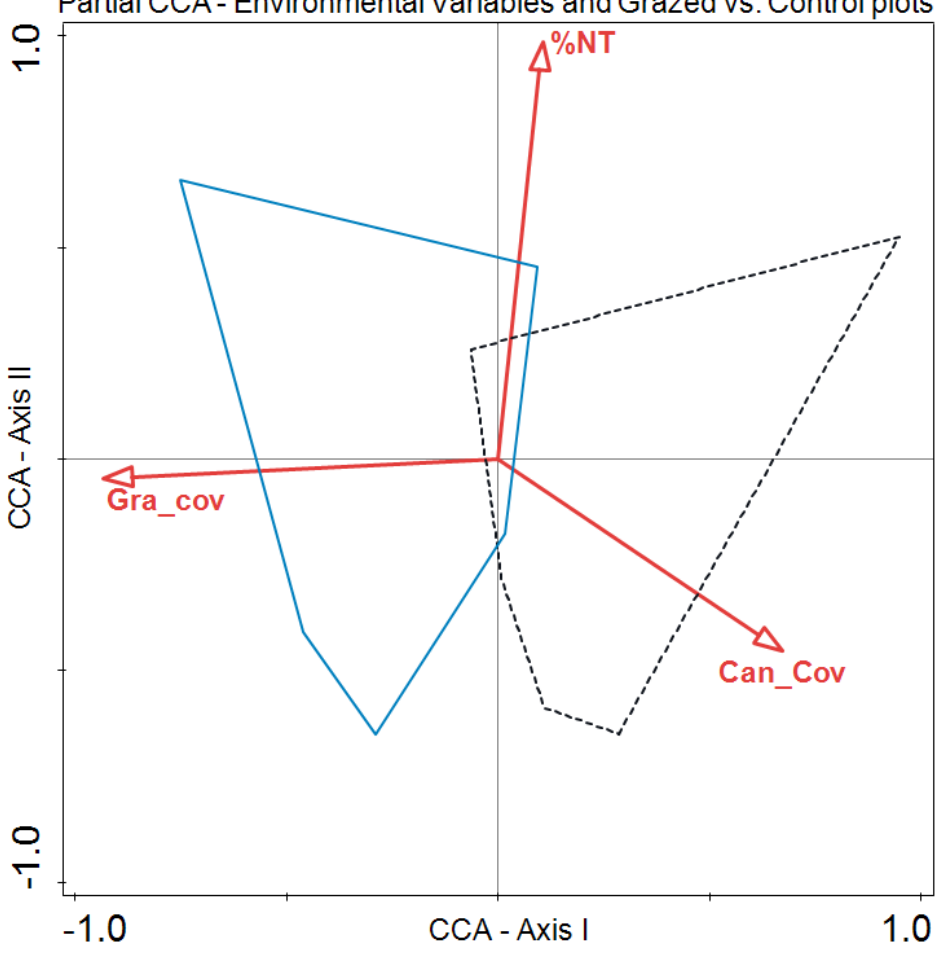
Figure 3. Canonical correspondence analysis using five selected environmental variables: grass cover (Gra-cov), canopy (Can_Cov), and total nitrogen (%NT). It also includes envelopes enclosing the two groups of plots (control-solid line) and grazed plots (dashed line). Eigenvalues axis I: 0.28; axis II: 0.20; both axes cumulative percentages explained for the species composition 19.5% and both axes cumulative percentages variance explained for the species-environmental relationship: 71.5%.